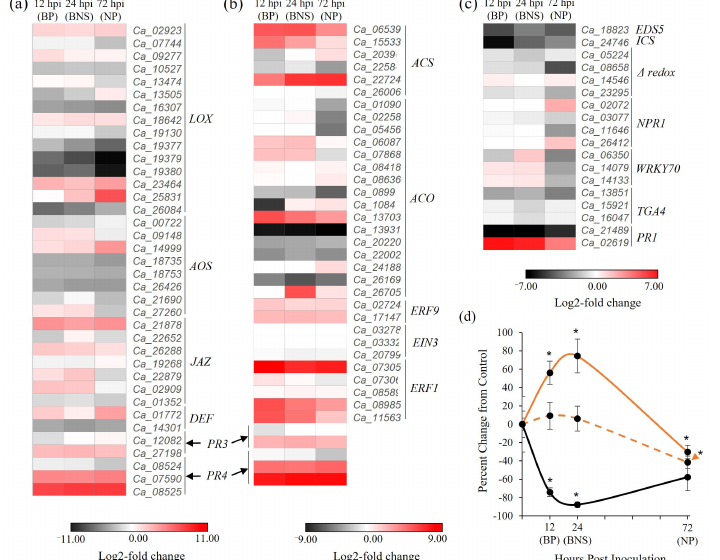
Figure 6. Jasmonic acid (JA), ethylene (ET), and salycilic acid (SA) signalling pathways in chickpea roots during the biotrophic to necrotrophic switch of Phytophthora medicaginis . ( a ) Expression profiles of the log2-transformed data of differentially regulated genes pertaining to the JA signalling pathways in chickpea var. ‘Sonali’ at 12, 24 and 72 h post-inoculation (hpi). Genes are annotated with Arabidopsis orthologue: LOX , lipoxygenase (Biosynthesis) ; AOS , allene oxide synthase (Biosynthesis); JAZ, jasmonate zim domain protein (Perception); DEF , defensin-like gene (Signalling); PR3 , pathogenesis- related 3 (Signalling); PR4 , pathogenesis-related 4 (Signalling). These latter two genes are also involved in ET signalling. ( b ) Expression profiles of the log2-transformed data of differentially regulated genes pertaining to the ET pathway in chickpea var. ‘Sonali’ at 12, 24, 72 hpi. Genes are annotated with the Arabidopsis orthologue: ACS, acc synthase (Biosynthesis); ACO, acc oxidase (Biosynthesis); ERF9, ethylene response factor 9 (Signalling); EIN3, ethylene insensitive 3 (Signalling); ERF1, ethylene response factor 1 (Ssignalling). ( c ) Expression profiles of the log2-transformed data of differentially regulated genes pertaining to the SA signalling pathways in chickpea variety ‘Sonali’ at 12, 24 and 72 hpi. Down-regulated genes and up-regulated genes are presented as black (low) or red (high), respectively. Genes are annotated with Arabidopsis orthologue: EDS5 , enhanced disease susceptibility 5 (Biosynthesis); ICS , isochorismate synthase (Biosynthesis); NPR1 , nonexpressor of pathogenesis-related 1 (Perception); WRKY70 , wall-associated receptor kinase 70 (Signalling); TGA4 , tcagc-binding factor 4 (Signalling); PR1 , pathogenesis-related 1 (Signalling). ( d ) Percent change in hormone concentrations in roots undergoing colonisation by P. medicaginis (compared to axenically grown control roots) for JA (orange solid line), JA-Ile (orange dashed line), and SA (black solid line). The error bars indicate standard error between 9–12 biological replicates at each timepoint; * = Significant difference from control values ( p < 0.05; Student’s T -test). BP: biotrophic phase, BNS: biotrophy to necrotrophy switch, NP: necrotrophic